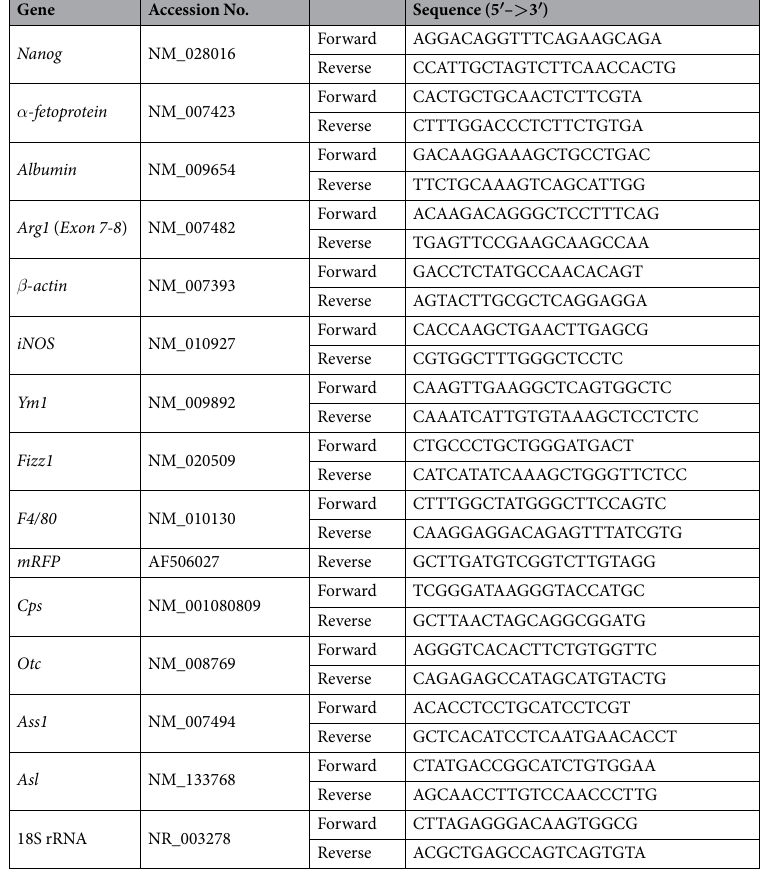
Table 1. Primer sequences for RT-PCR analysis. iNOS , inducible nitric oxide synthase; Ym1 , chitinase- like 3 ( Chil3 ); Fizz1 , resistin-like alpha ( Retnla ); Cps , carbamoyl-phosphate synthetase 1; Otc , ornithine transcarbamylase; Ass1 , argininosuccinate synthetase 1; Asl , argininosuccinate